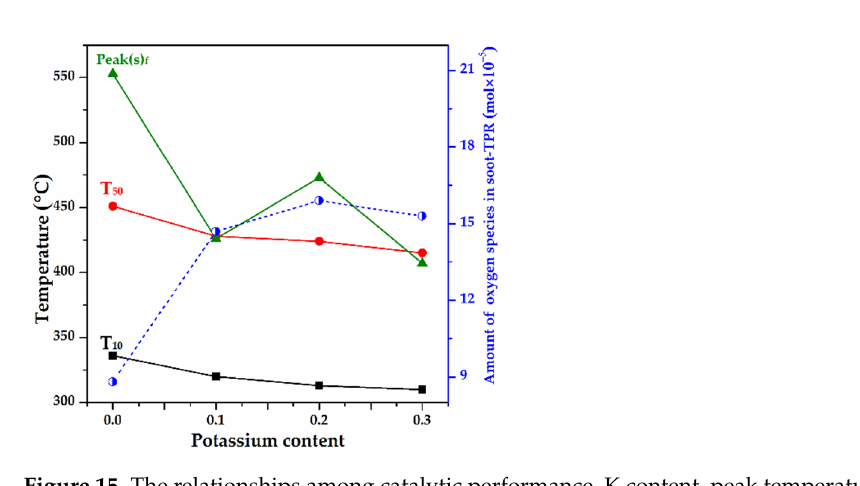
Figure 14. The relationships among catalytic performance, K content, peak temperature of H 2 -TPR and active oxygen in as-prepared monolith catalysts.